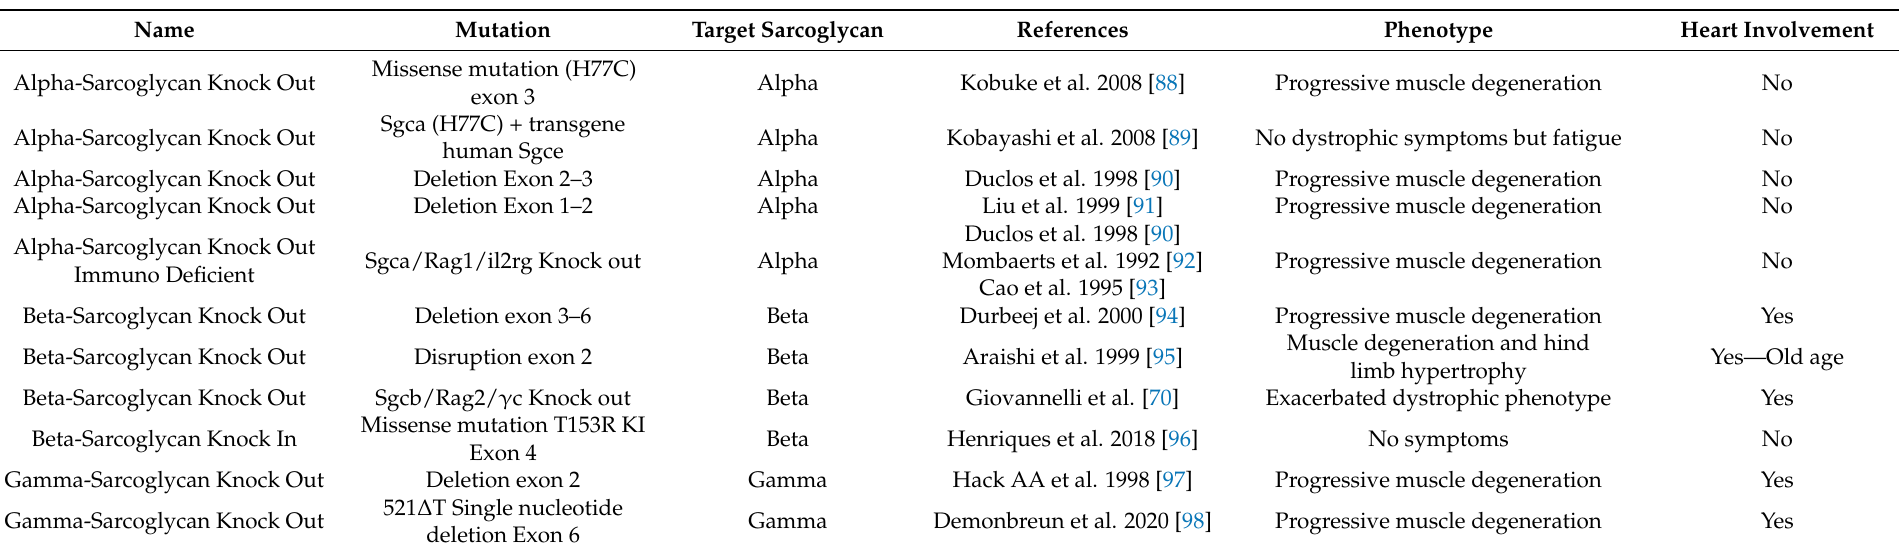
Table 1. Summary of sarcoglycanopathies mouse